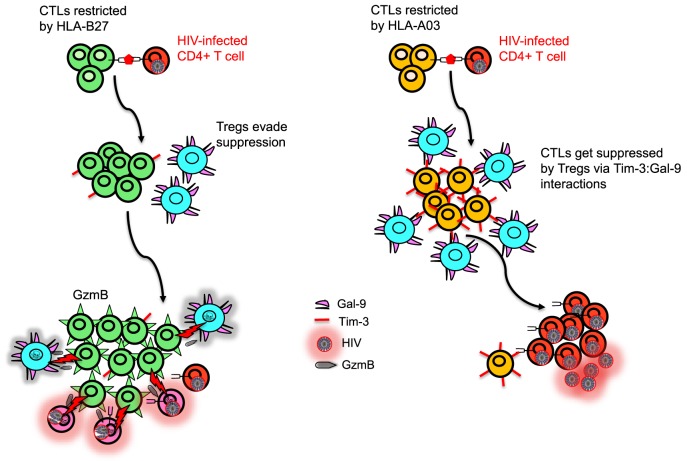
Model depicting differential regulation by CD8+ T cells restricted with different human leukocyte antigen (HLA) alleles. HLA-B27 and/or B57-restricted CD8+ T cell do not upregulate T-cell immunoglobulin and mucin domain-containing molecule 3 (Tim-3) upon recognition of their cognate epitopes on human immunodeficiency virus (HIV)-infected CD4+ T cells, whereas HIV-specific non-B27/B57 such as A03-restricted CD8+ T cell upregulate high levels of Tim-3. Regulatory T cells (Tregs) express Galectin 9 (Gal-9) and suppress and kill A03-restricted CD8+ T cells due to their high expression of Tim-3 but cannot suppress proliferation of B27-restricted CD8+ T cells. Polyfunctional B27-restricted CD8+ T cells upregulate high levels of granzyme B (GzmB) and kill not only infected CD4+ T cells but also Tregs that they encounter. Therefore, B27-restricted CD8+ T cells are capable of keeping HIV replication in control during chronic infection, whereas A03-restricted CD8+ T cells lack this ability.